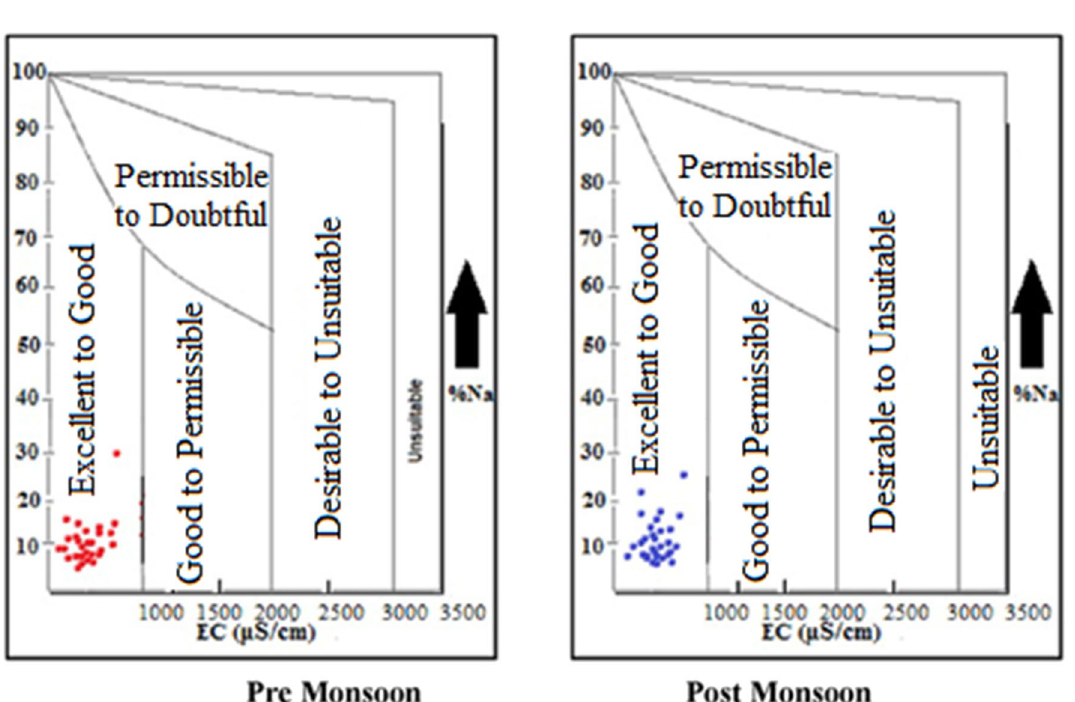
Fig. 8 Wilcox diagram of groundwater in the study